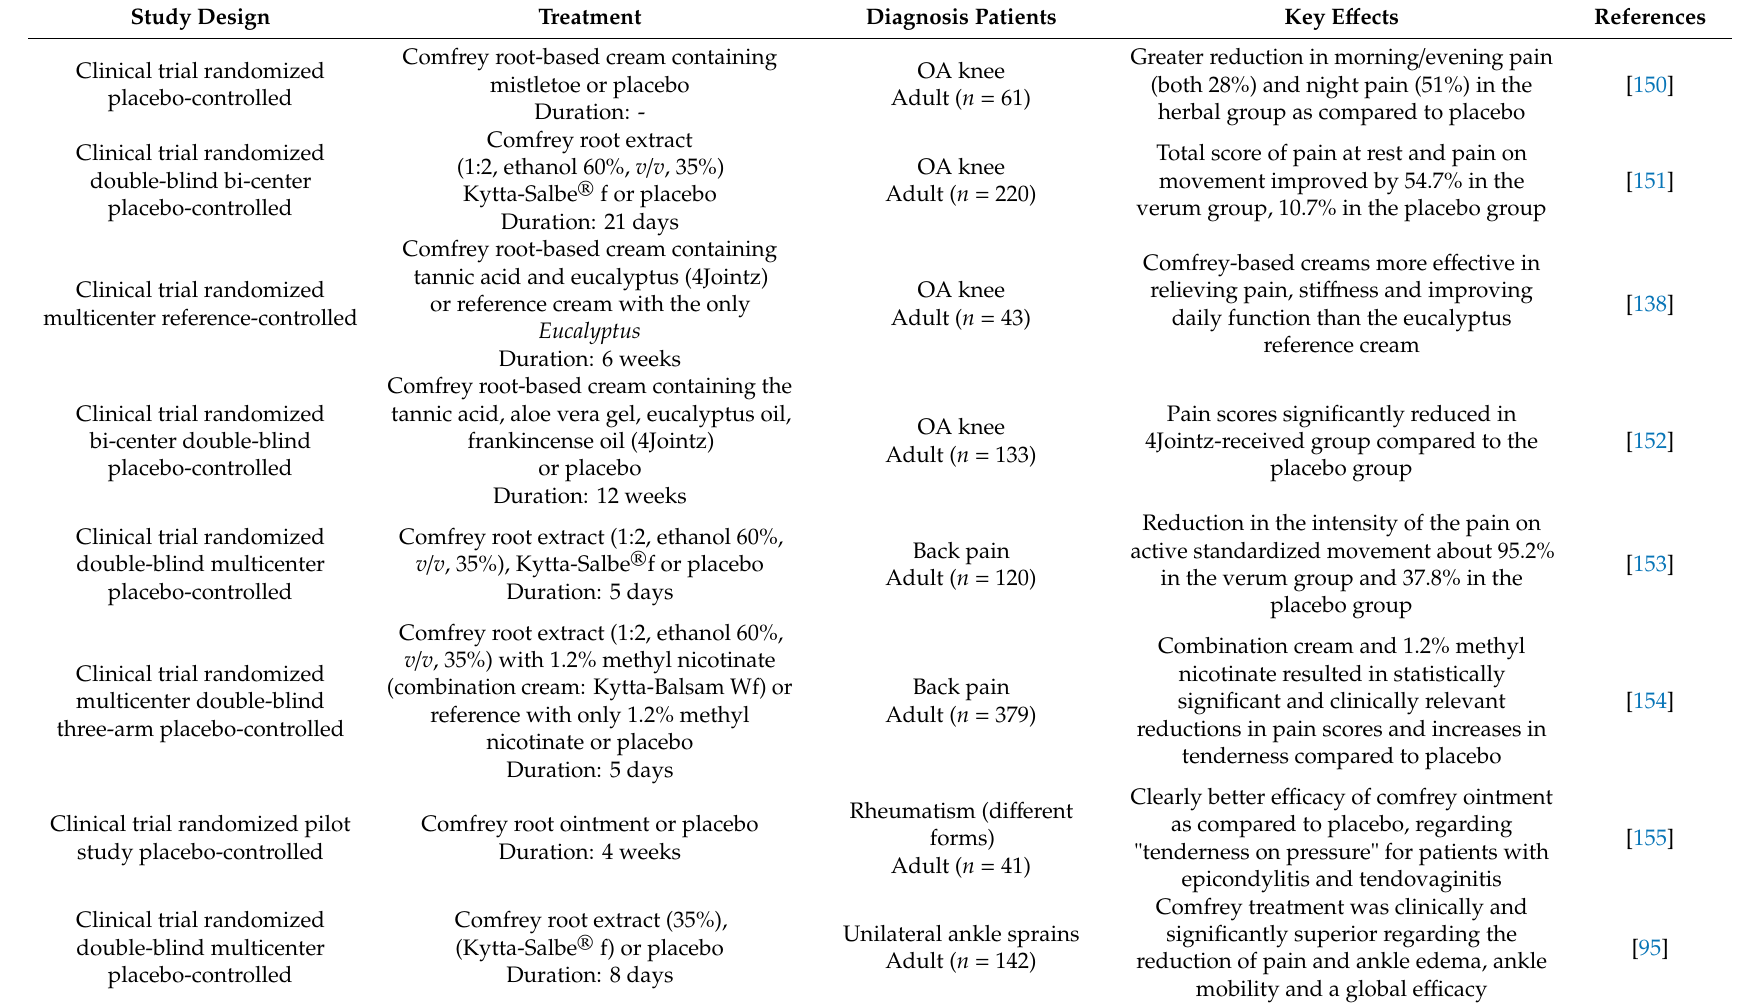
Table 6. Clinical trials with Symphytum